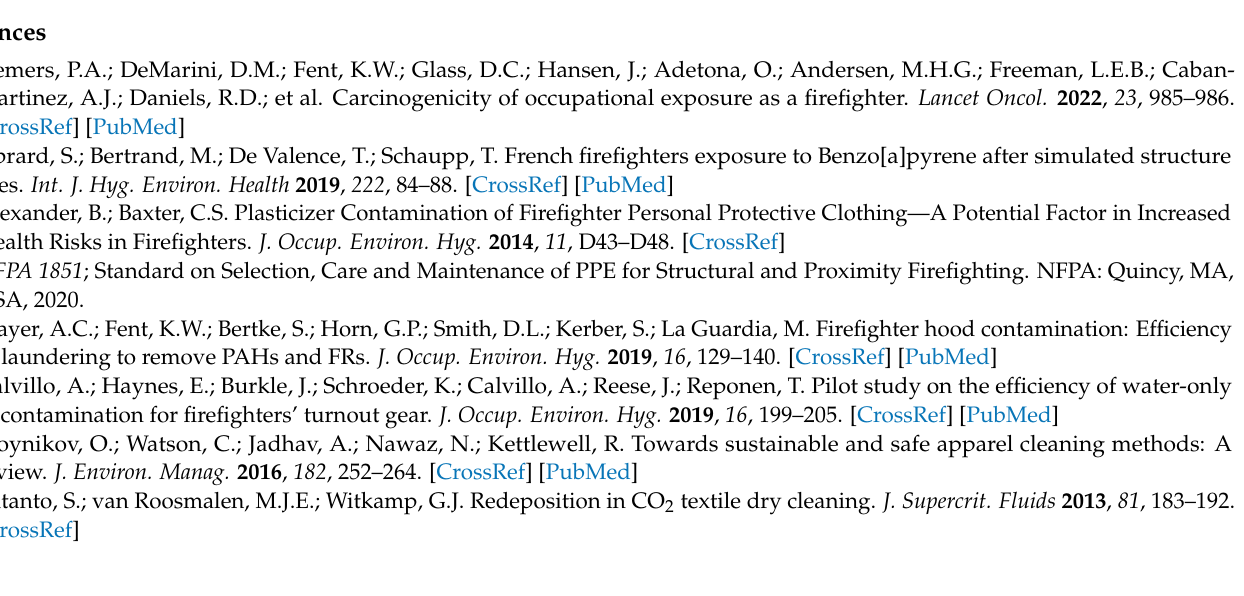
Figure S4: Box-Plot of average washing efficiencies of all compounds (when equal number of samples are considered). Figure S5: Normality test for equal number of samples (Left: Conventional washing, Right: liquid CO 2 washing). Figure S6: t -Test analysis (Equal number of